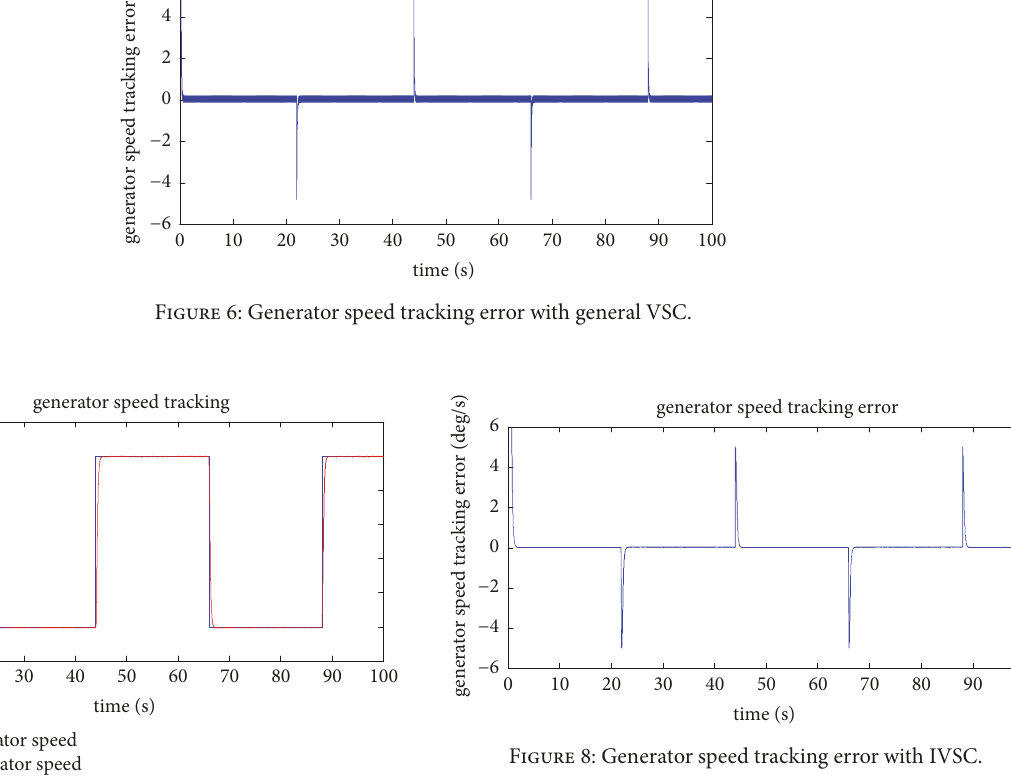
Figure 7: Generator speed tracking with IVSC.